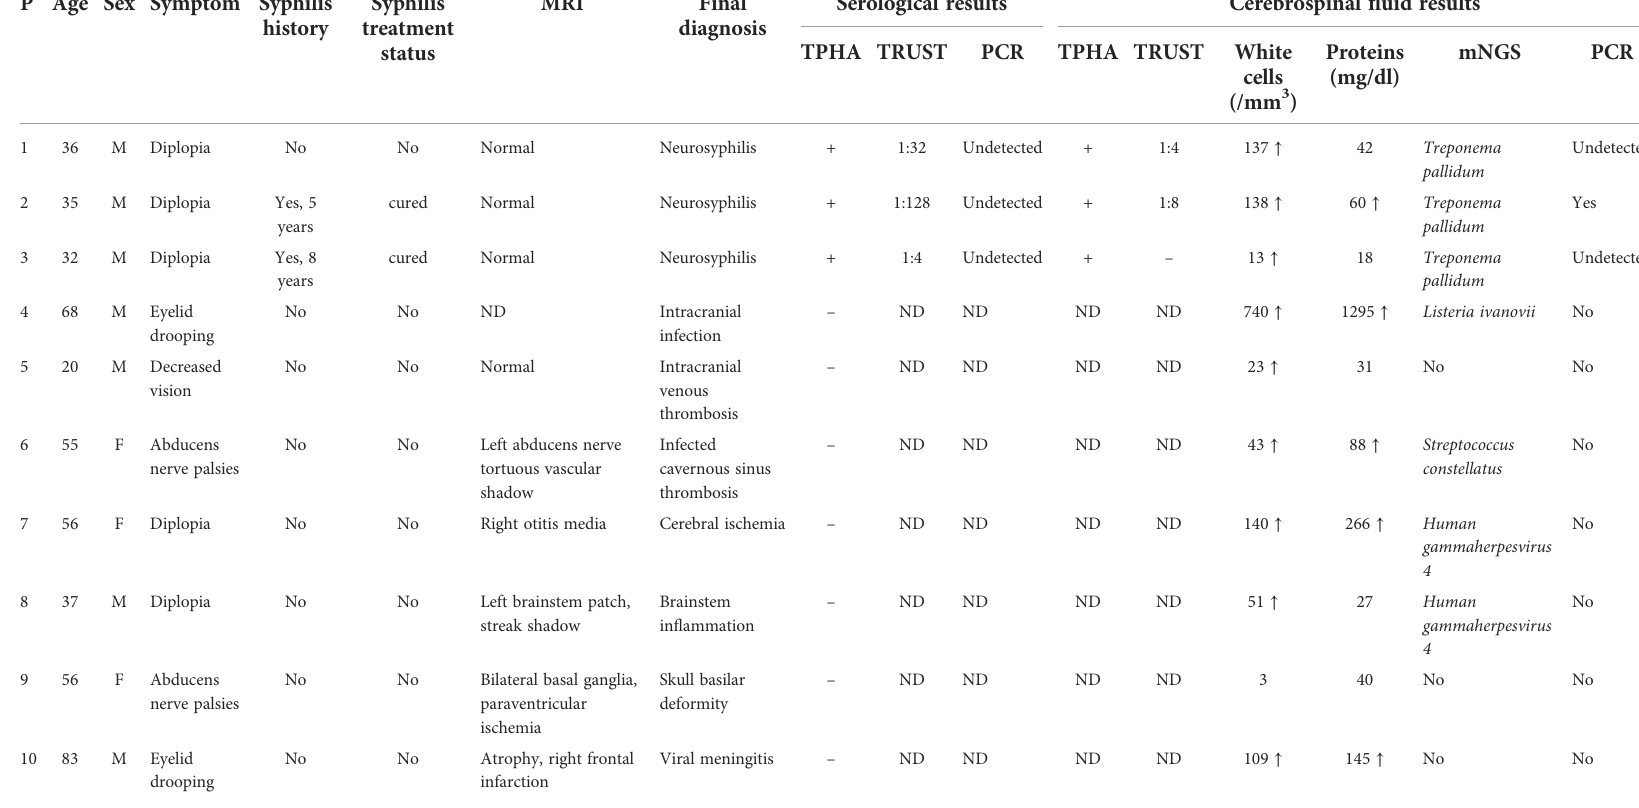
TABLE 1 Clinical characteristics and laboratory tests of the 10 patients with ocular